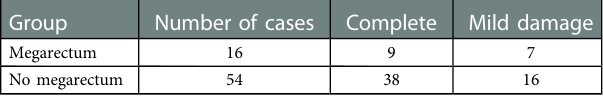
TABLE 3 Comparison of postoperative sphincter score between the two groups. Group